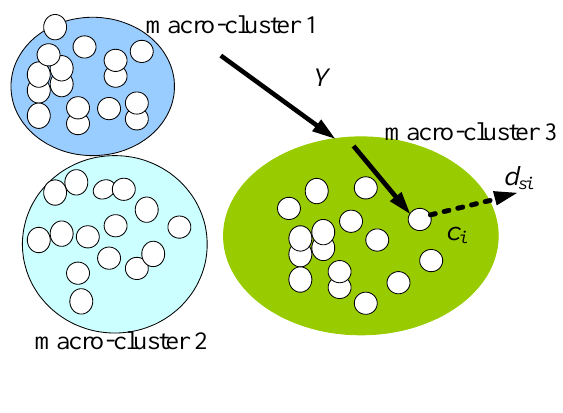
Figure 6. Macro-cluster and RSSI-D